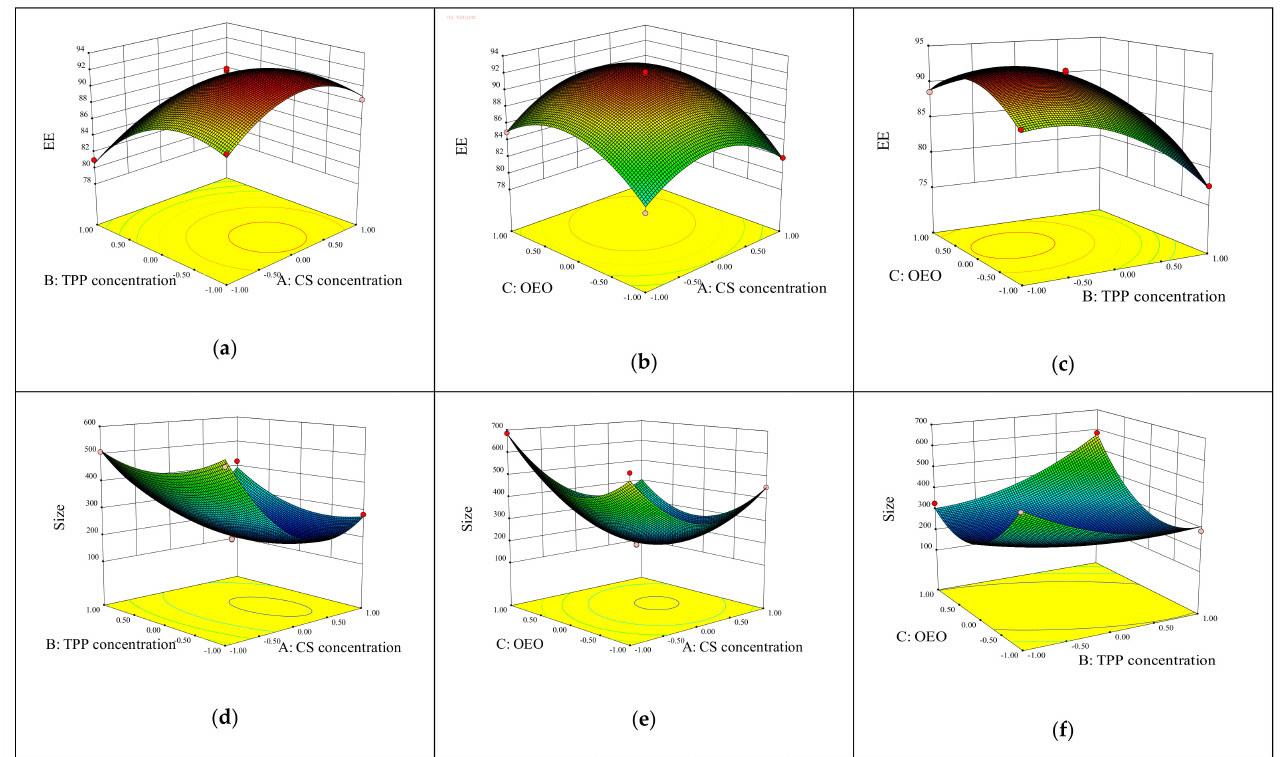
Figure 2. The three-dimensional surface representation of the experiment. Plots ( a – c ) and ( d – f ) show the effects of CS concentration (A), TPP concentration (B), and OEO addition (C) on the EE% and particle size of OEO-CSNPs, respectively.